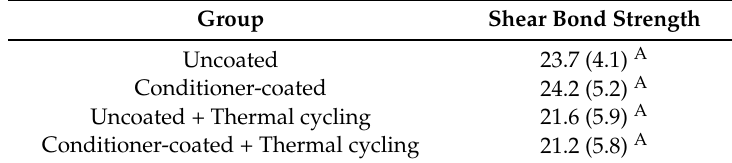
Table 3. Mean (standard deviation) shear bond strength value of each group in MPa.